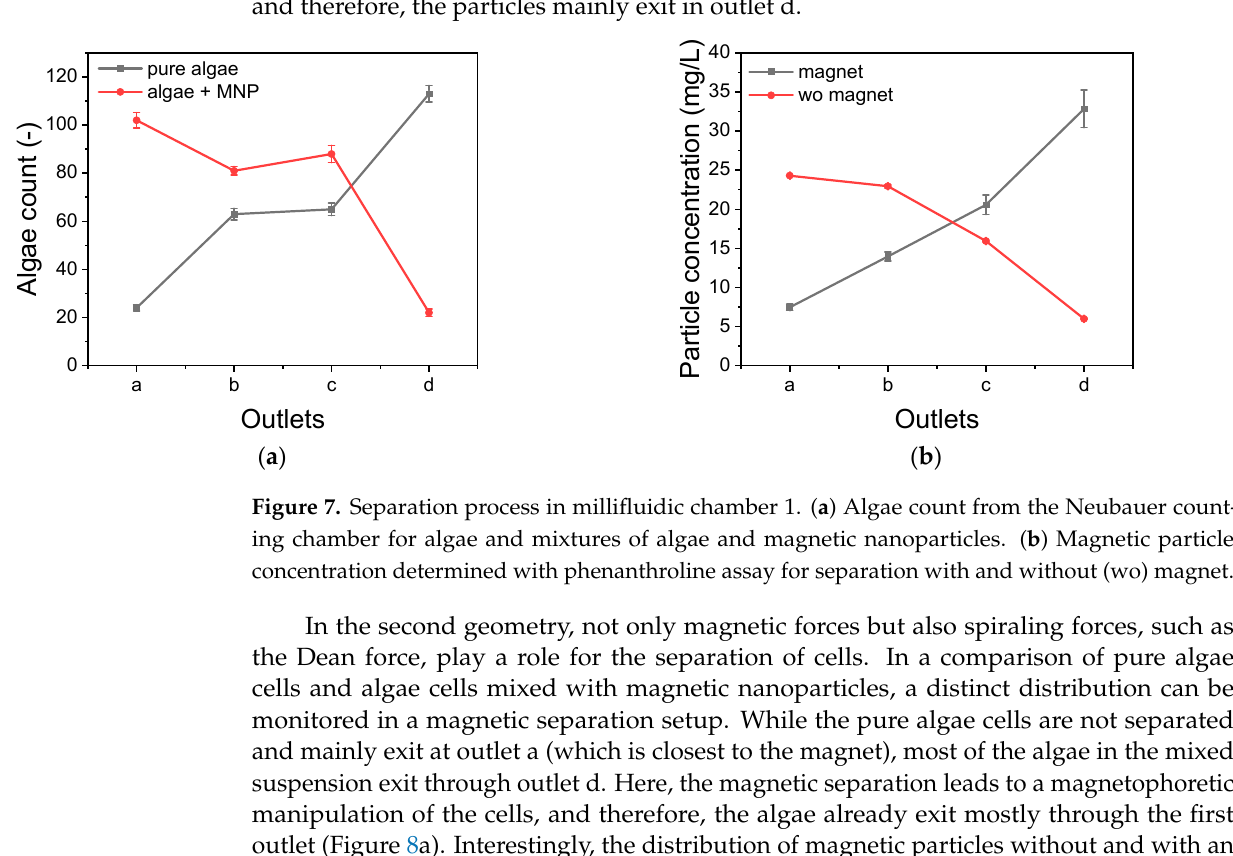
Figure 7. Separation process in millifluidic chamber 1. ( a ) Algae count from the Neubauer counting chamber for algae and mixtures of algae and magnetic nanoparticles. ( b ) Magnetic particle concen ‐ tration determined with phenanthroline assay for separation with and without (wo) magnet.